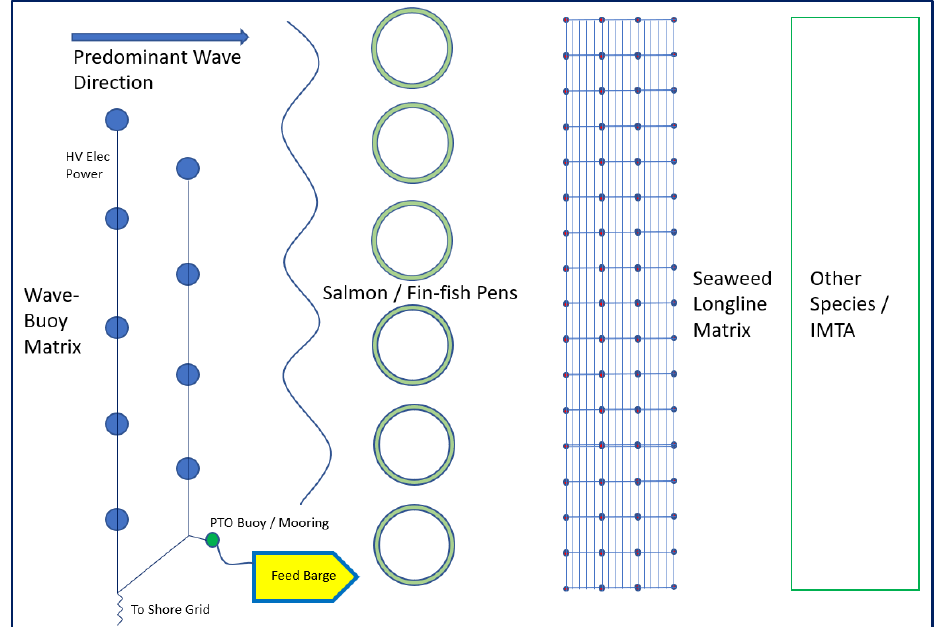
Figure 28. Grid connected-wave buoy powered feed barge, IMTA seaweed system concept.